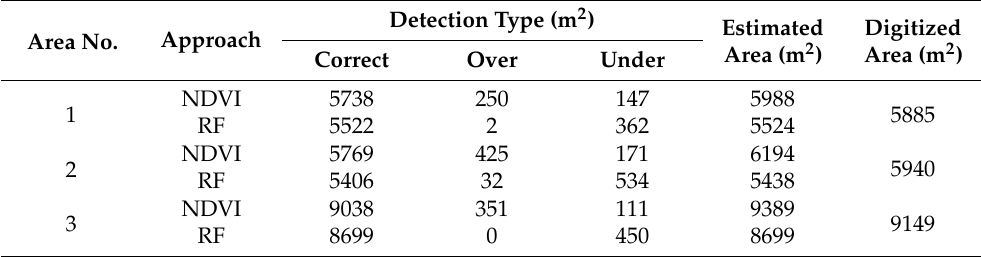
Table 2. Water hyacinth detected area (m 2 ) type (correct, over, and under) when using the normal- ized difference vegetation index (NDVI) and when applying a random forest (RF) in the three areas surveyed by the unmanned aerial vehicle.